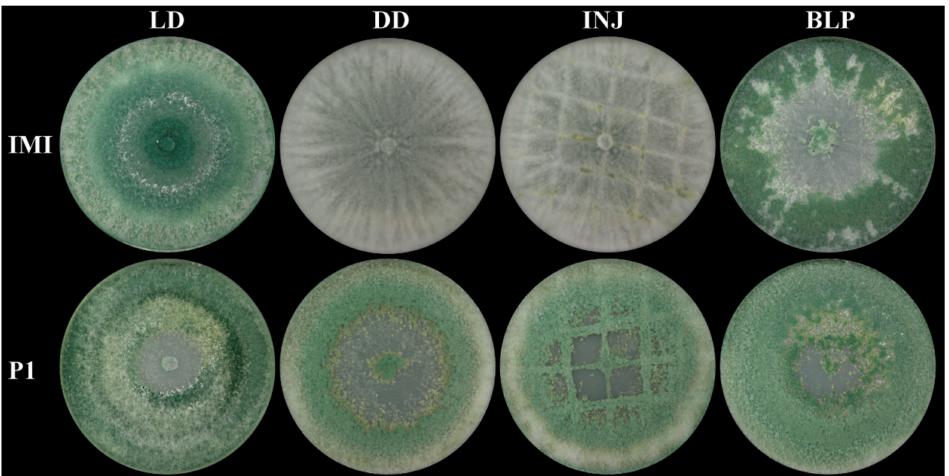
Figure 2. Strain-specific di ff erences in conidiation upon growth under di ff erent light regimes and upon mechanical injury. T. atroviride P1 (P1) and T. atroviride IMI 206040 (IMI) were grown on PDA at 25 ◦ C for five days under light-dark (LD) conditions or in complete darkness (DD). For induction of conidiogenesis, the fungi were grown in complete darkness for two days, treated by either mechanical injury (INJ) or a 10 min blue-light pulse (BLP) followed by incubation for further three days in complete darkness. A representative image of four biological replicates ( n = 4) is